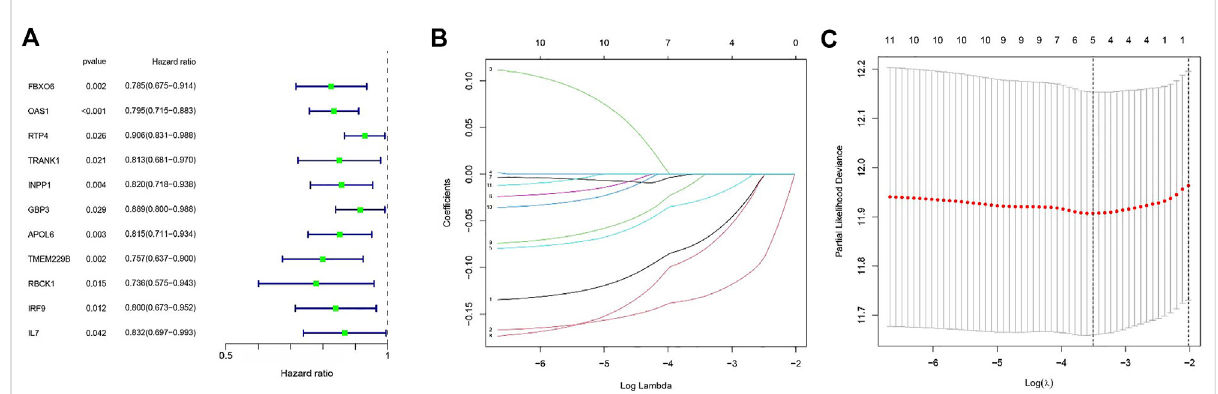
FIGURE 2 (A) Outcomes of univariate cox regression analysis. (B) LASSO coef fi cient pro fi les of 11 candidate genes. A vertical line is drawn at the value chosen by 10-fold cross-validation. (C) The setting parameters selected in the regression process were cross checked ten times. The vertical line represents the fi nal three genes according to the best data.